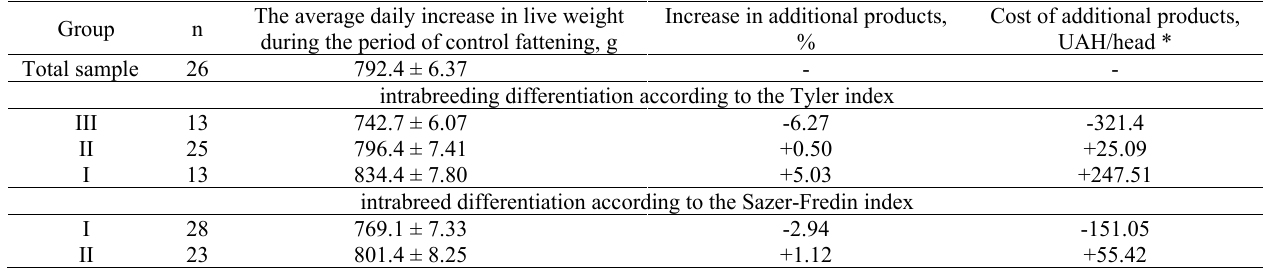
Economic efficiency of research